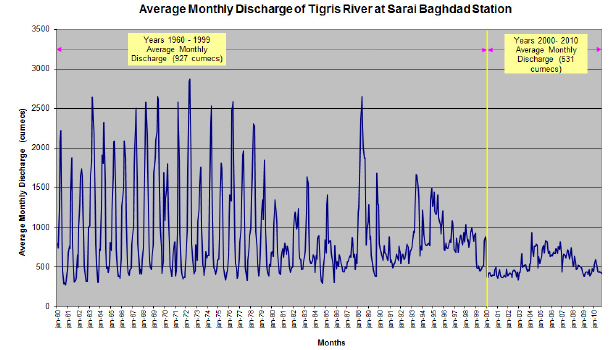
Fig. 2. Recorded Tigris River flow at Sarai Baghdad station for the period 1990–2010. Data source: Al-Shahrabaly